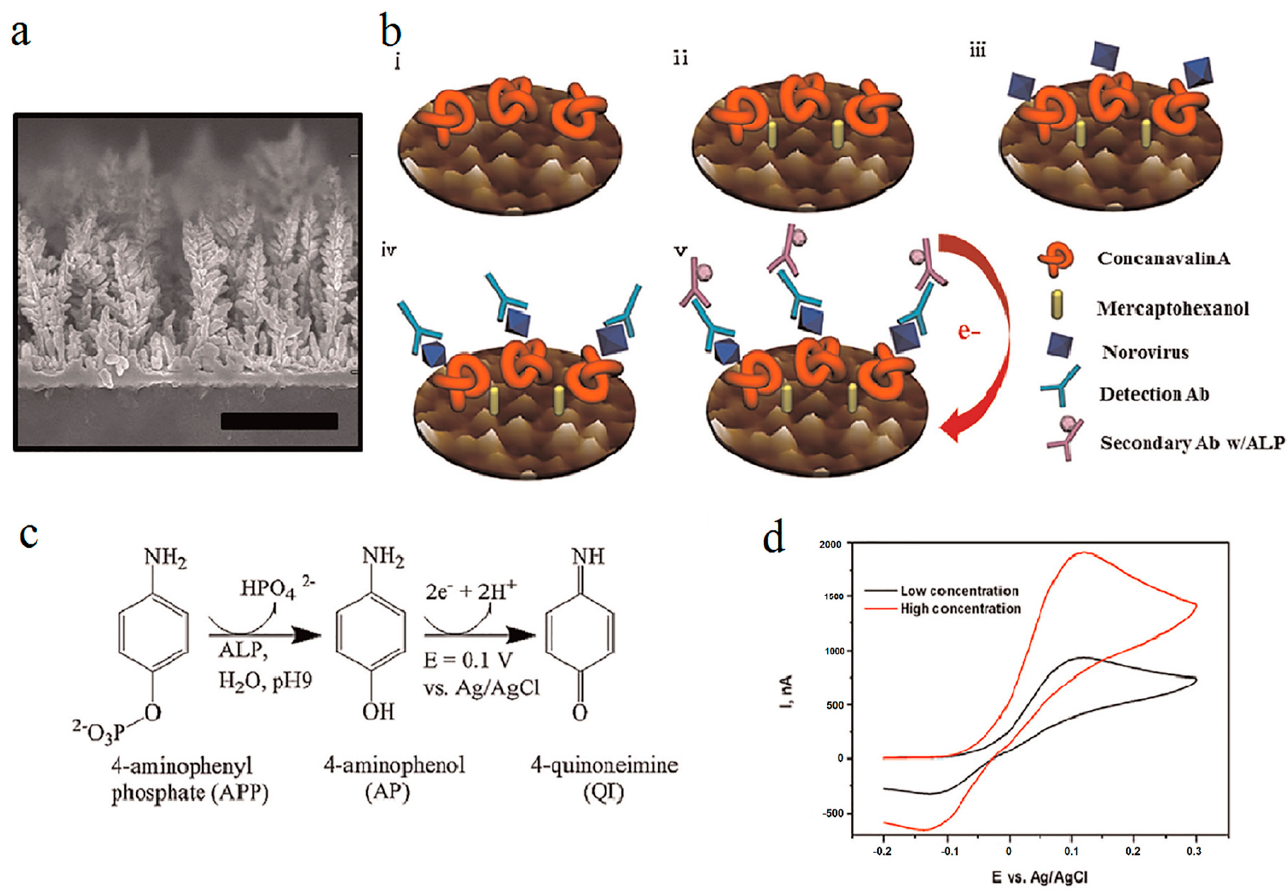
Figure 5. Preparation and characterization of concanavalin A (ConA)-based electrochemical biosensor. ( a ) The scanning electron microscope (SEM) image. ( b ) Schematic illustration of biosensor: ( b ( i ))